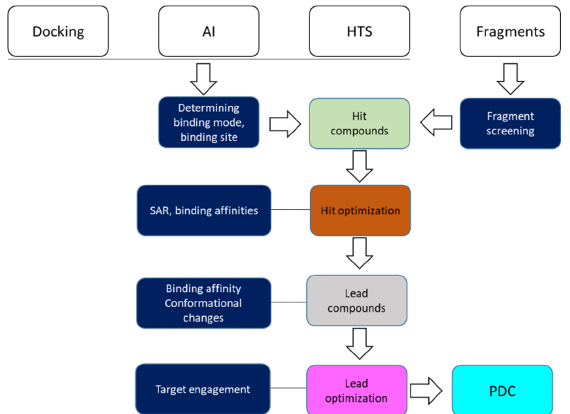
Figure 1. Overview of nuclear magnet resonance (NMR) spectroscopy involved in steps of drug discovery. Hits can come from in silico docking, design with artificial intelligence (AI), high-throughput screening (HTS), and compound fragments. The boxes highlighted in blue are the steps in which NMR can play a role. A preclinical development candidate (PDC) is a compound that is ready for clinical studies.